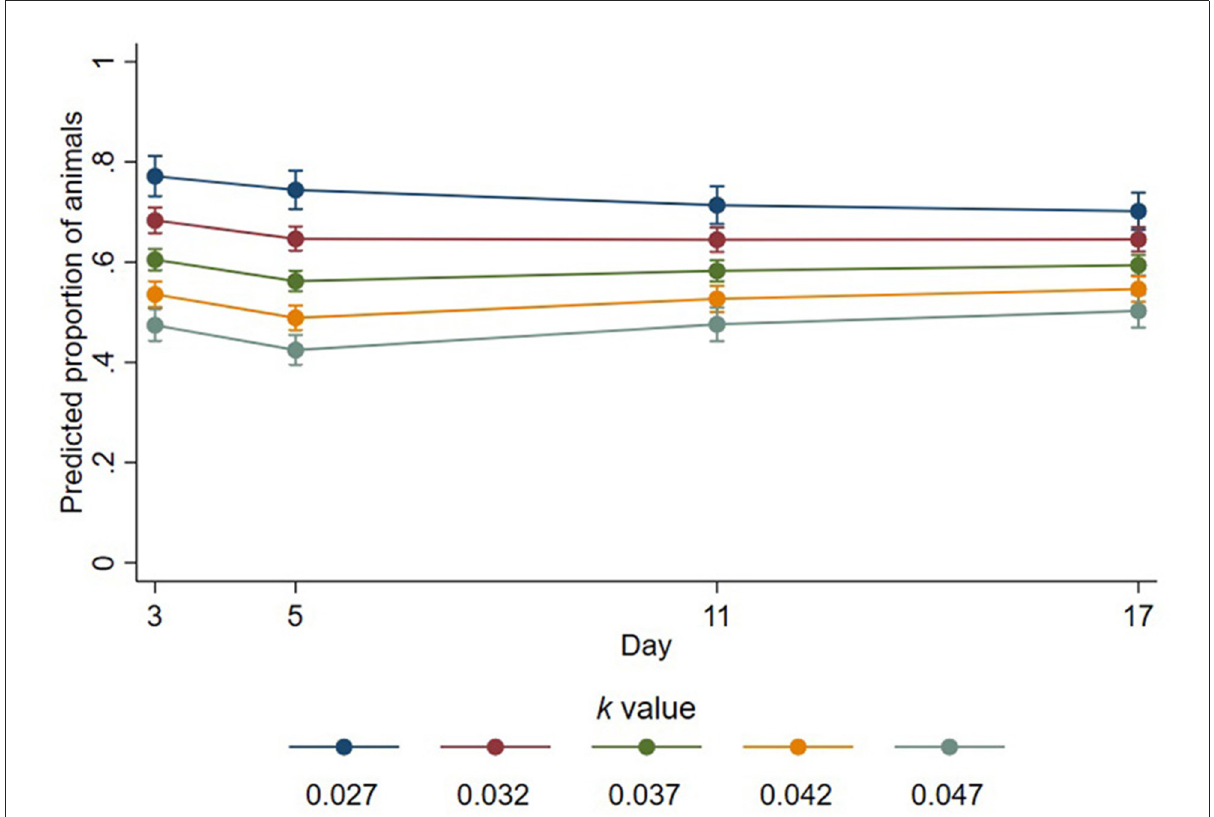
FIGURE3 Predicted proportions of animals lying with their head down that place their head on a conspecific at different k -values across days. Error bars represent 95% confidence intervals of predicted proportions. Predicted proportions were calculates as predicted numbers divided by the average number of sheep lying at each time point